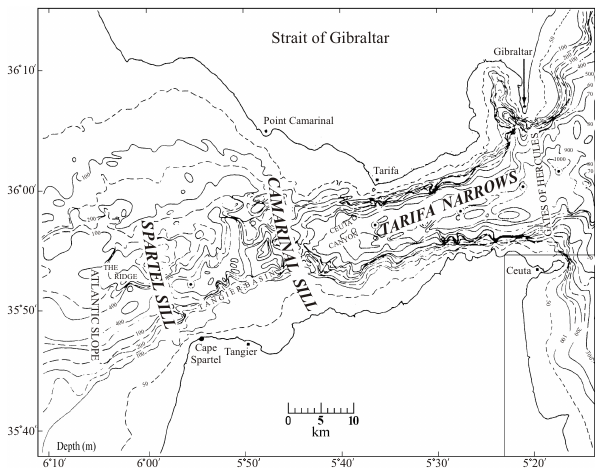
Fig. 5. The bathymetry of the Strait of Gibraltar (Lacombe and Richez, 1982).